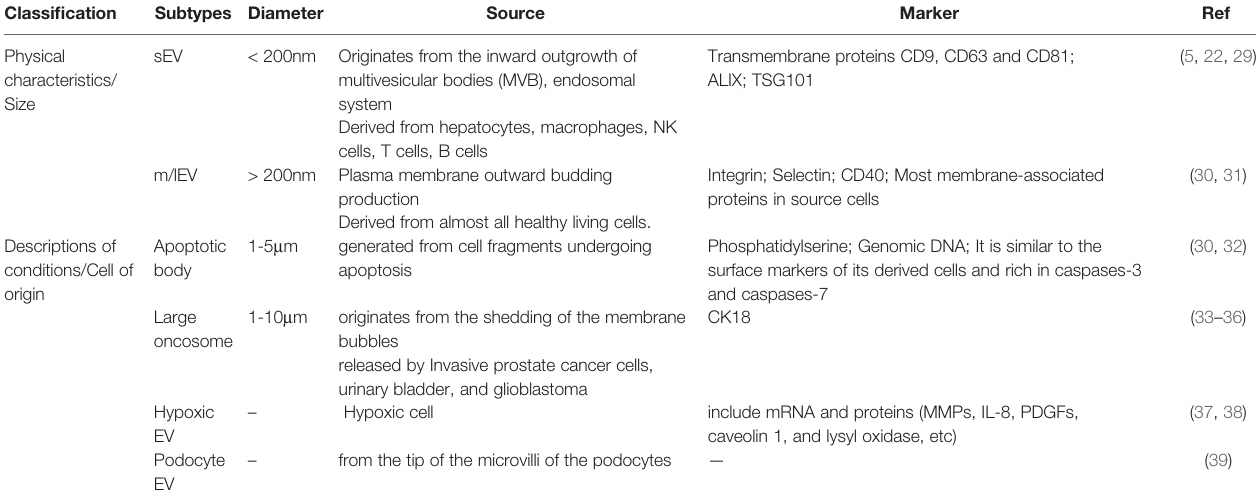
TABLE 1 | The types of